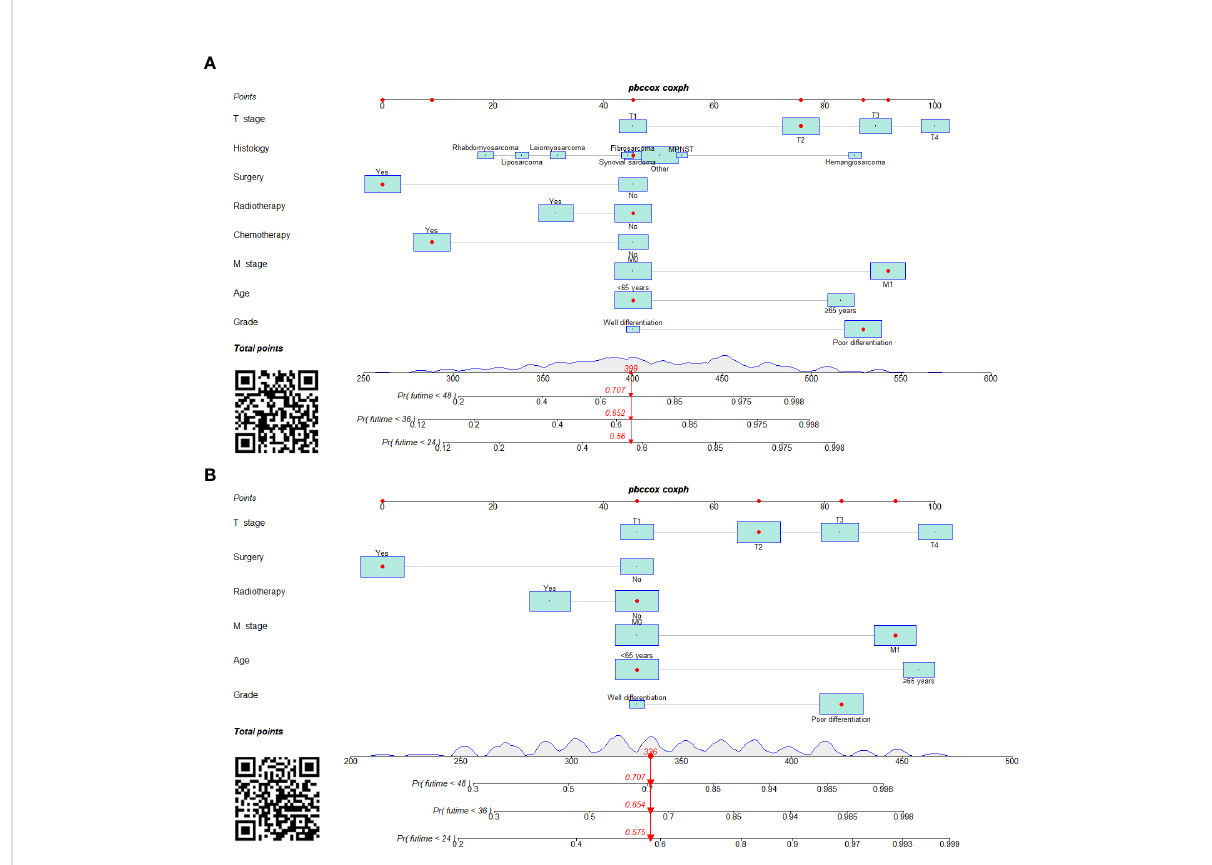
FIGURE 6 Prognostic nomograms in predicting 24-, 36-, and 48-month OS (A) and CSS (B) for patients with STS with